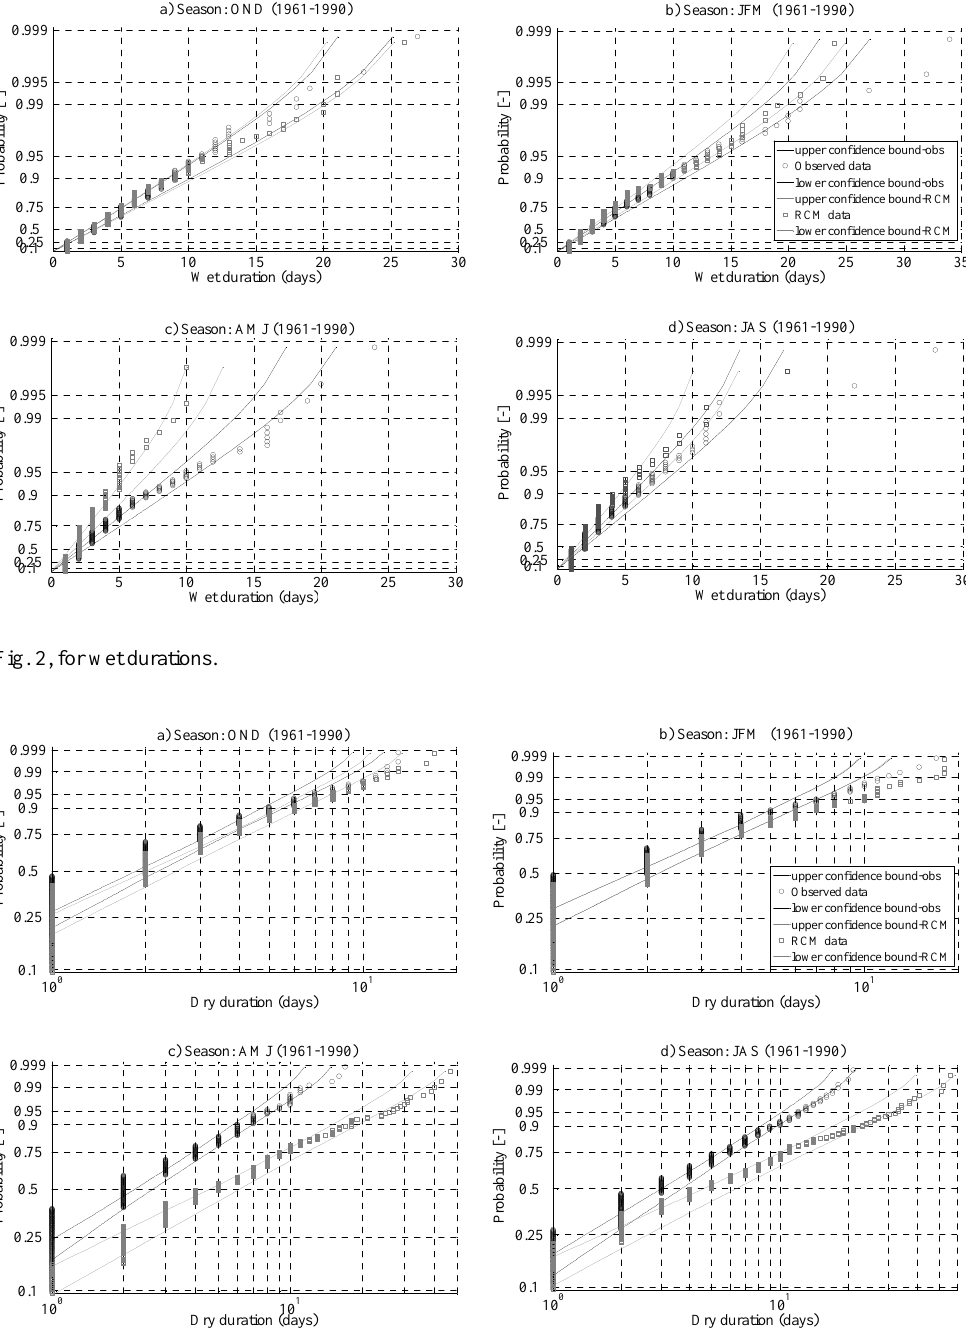
Fig. 4. Same as Fig. 2, for dry periods in Weibull probability